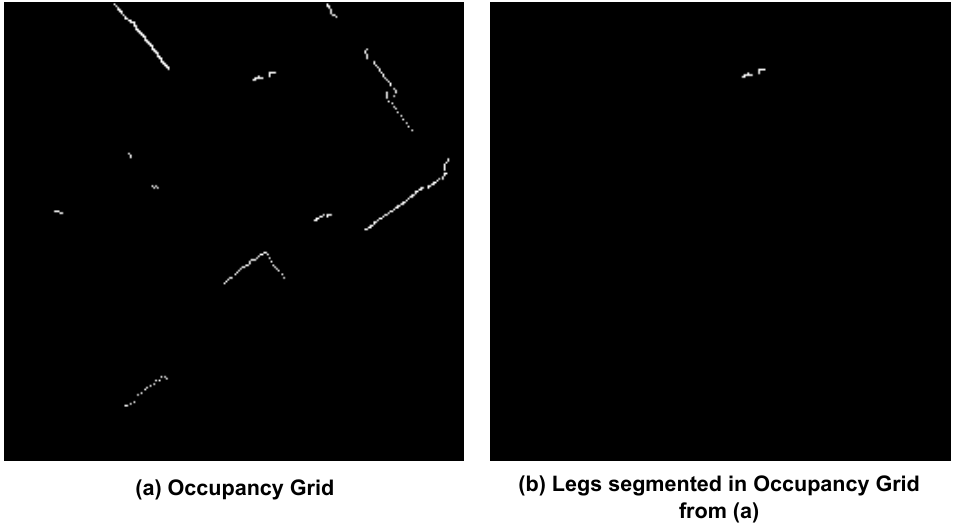
Figure 3. ( a ) Occupancy grid from LIDAR data; ( b ) leg detection from our prior work (right)